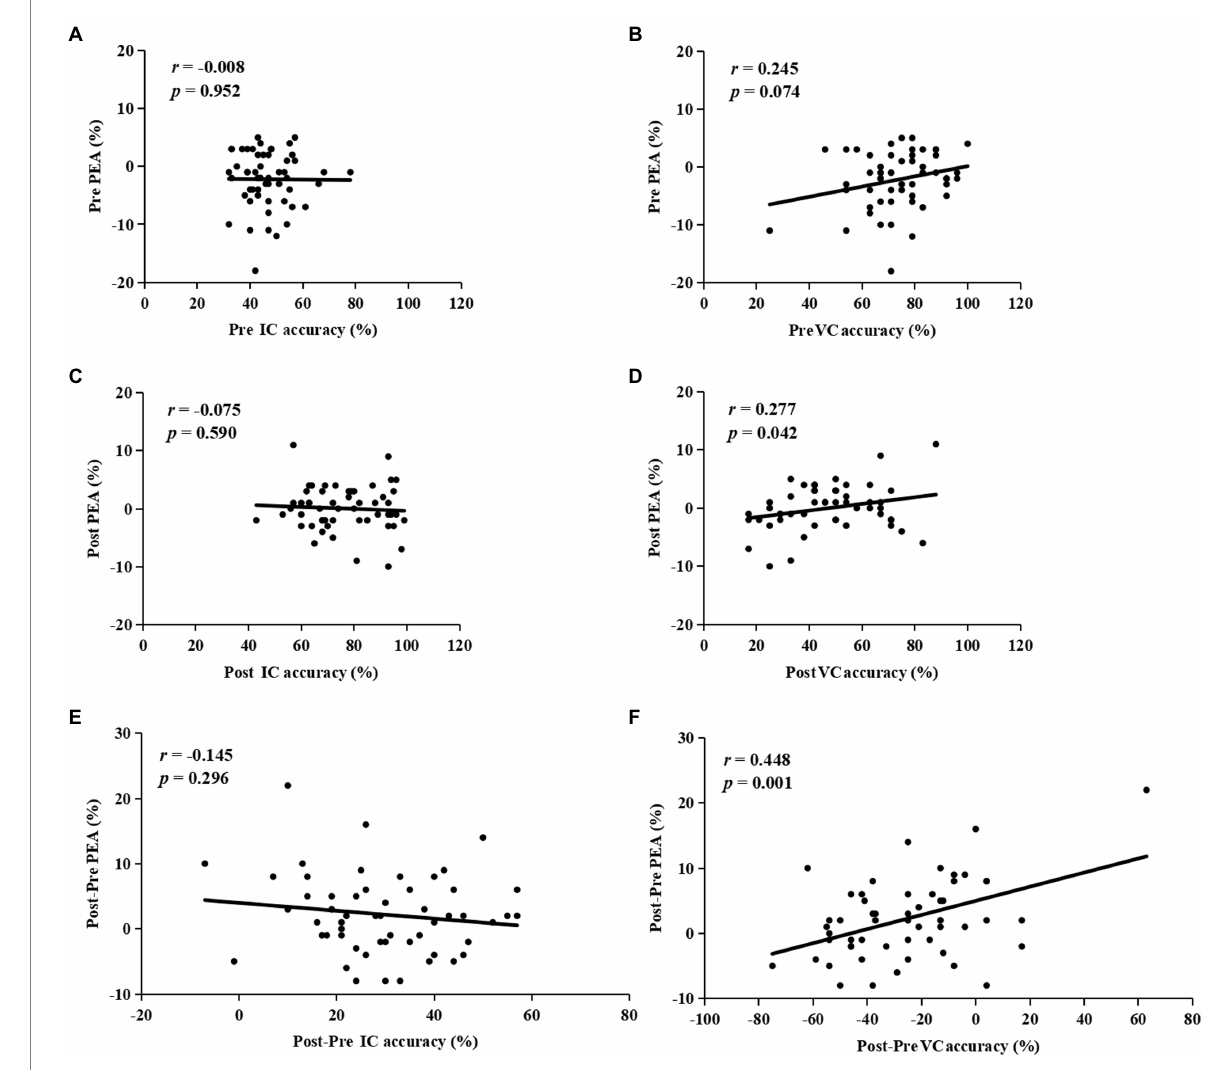
FIGURE 6 The correlations between the accuracy of invalid cue (IC) or valid cue (VC) trials and the post-error accuracy (PEA) at pretest (A,B) , and posttest (C,D) . The correlations between Post-Pre IC accuracy (E) , or Post-Pre VC accuracy (F) , and Post-Pre